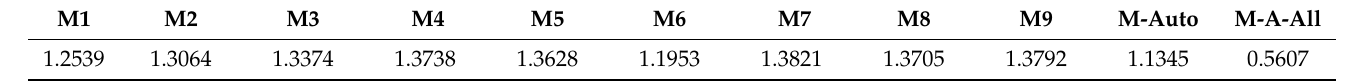
Table 5. Impact of different metagraphs in Yelp dataset.